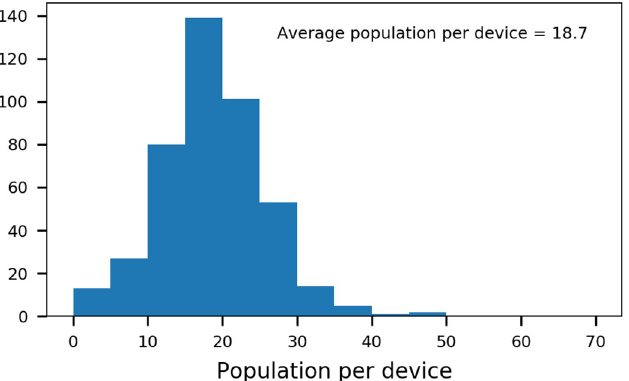
Fig 2. Distribution of population per device. Population per device was computed using each CBG in Bernalillo County, NM.